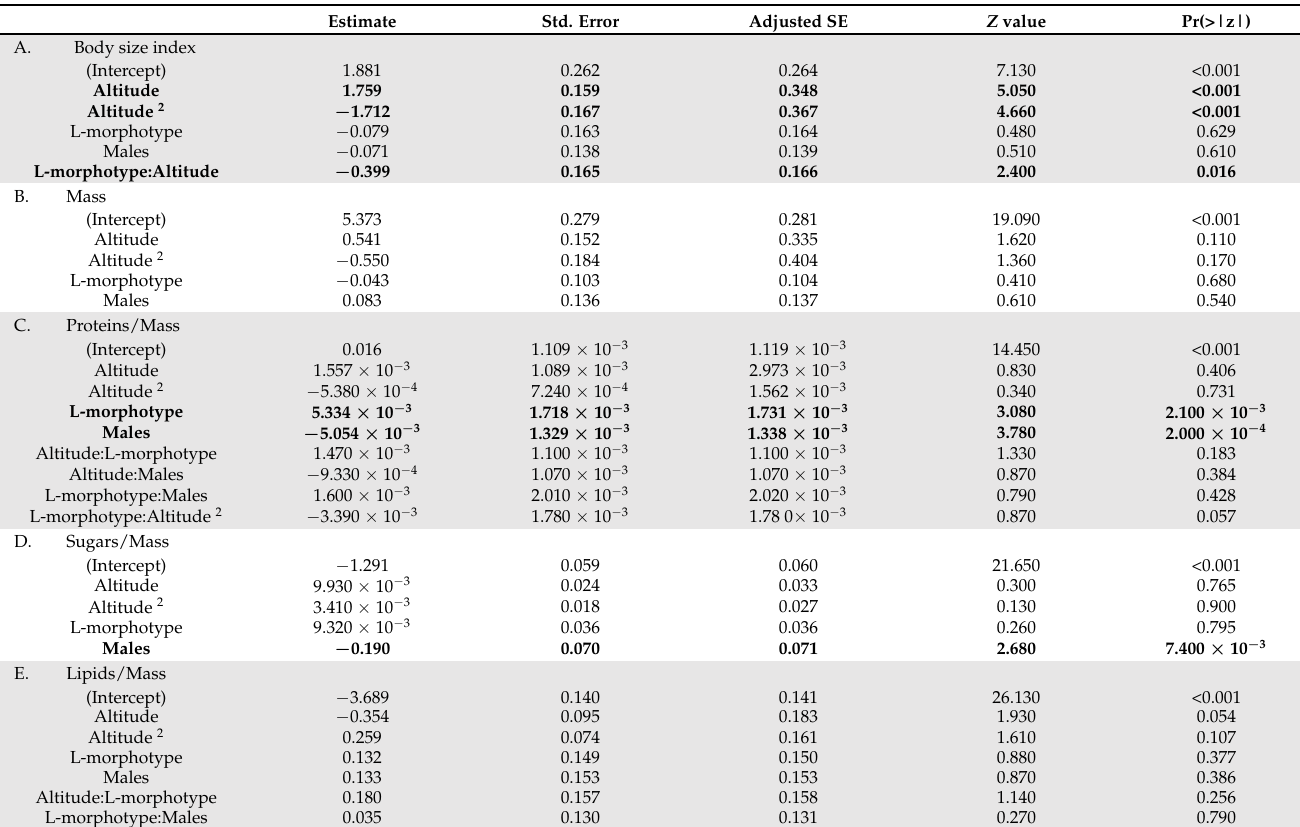
Table 1. Effects of altitude, morphotype, sex, and their interactions on each functional trait. This table presents the results from the full averages of the best-fitting linear mixed-effects models selected through an AIC comparison. Functional traits are used as response variables in the following tables: A —Body size index; B —Mass; C —Proteins/mass; D —Sugars/mass; and E —Lipids/mass. A bold font indicates statistical significance. Std. Error—standard error; Adjusted